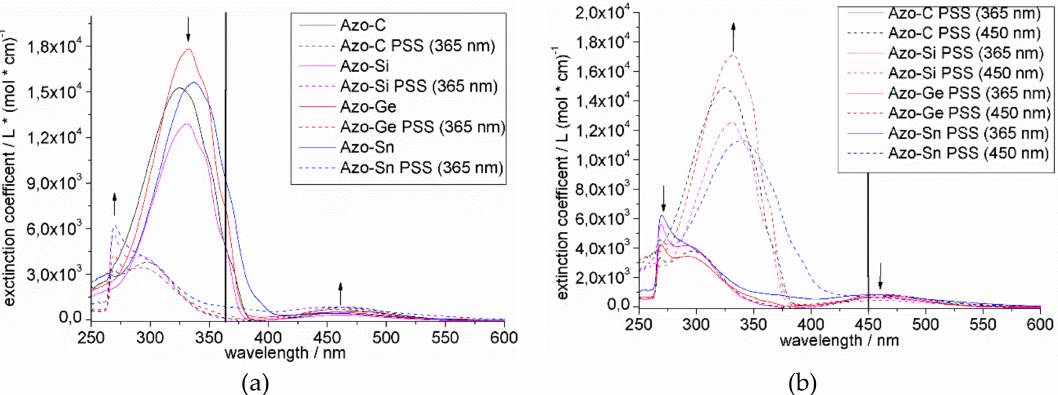
Figure 3. ( a ) Absorption spectra of azobenzenes 6 , 7 , 8 and 10 before and after irradiation with 365 nm light for 3 min. ( b ) Absorption spectra of azobenzenes 6 , 7 , 8 and 10 after irradiation with 365 nm light for 3 min, followed by irradiation with 450 nm light for 3 min. In each case, the black vertical lines indicate the irradiation